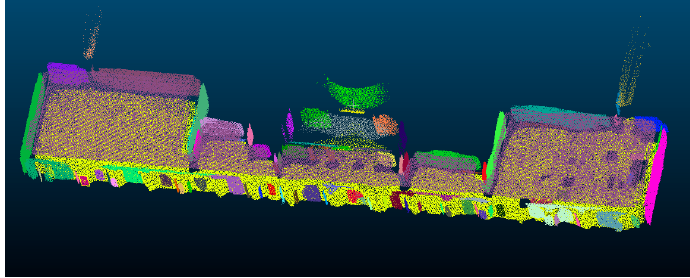
Figure 15. Scenario 2 Plane Segmentation.